Question: What does this figure show? Answer in one sentence.
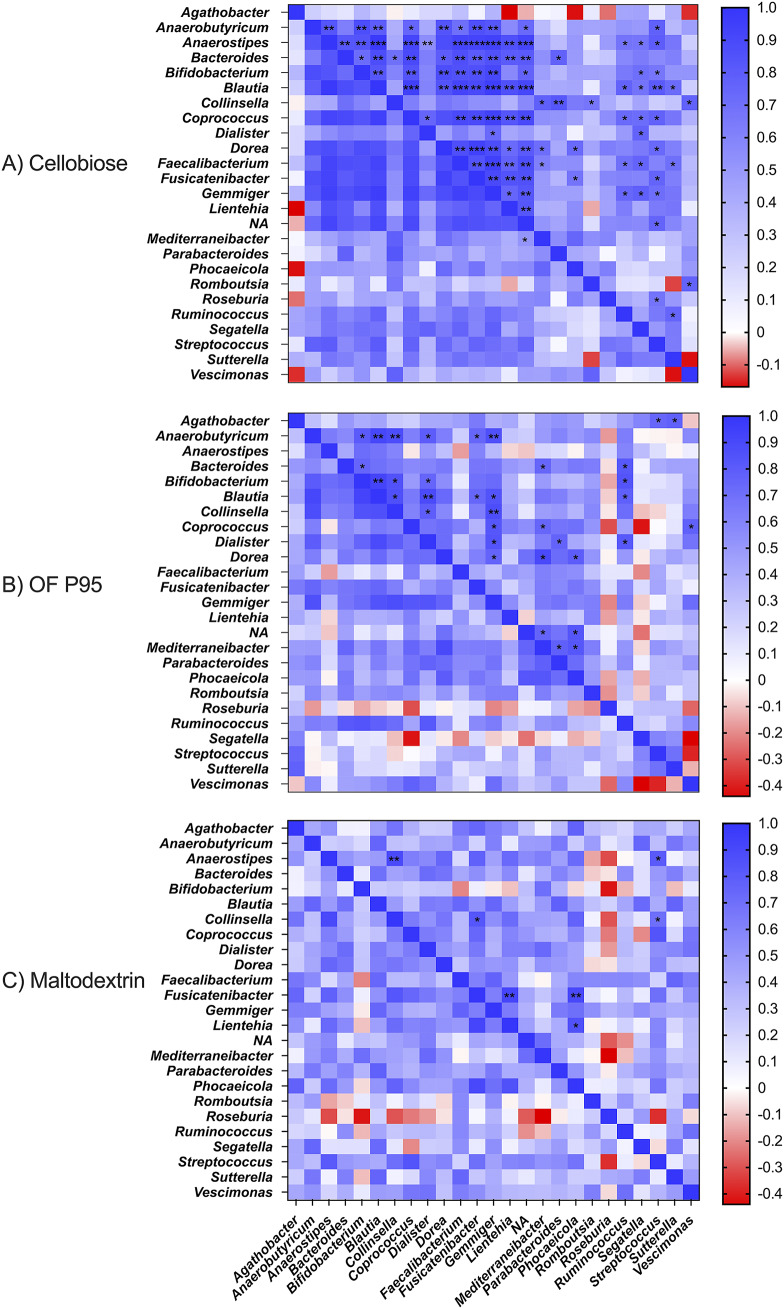
Answer: Heatmap of Spearman genus–genus correlations within each intervention. Cell colour reflects correlation coefficient (blue = positive, red = negative). Asterisks (* P ≤ less than or equals 0.5; ** P ≤ less than or equals 0.01; *** P ≤ less than or equals 0.001) denote correlations significant after BH-FDR correction; only the upper triangle of each symmetric matrix is annotated to avoid duplication. Abbreviations: OF P95, oligofructose P95; NA, not assigned at the sequencing level. Figure 6. long description.